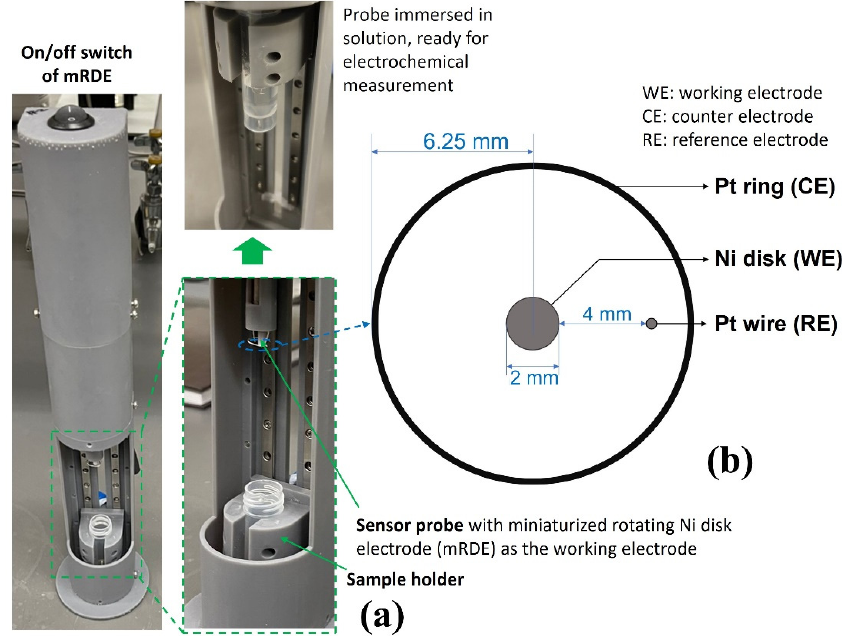
Figure 6. ( a ) UFC ‐ 19 Sensor used in experiments. The testing solution was put in the sample holder and slid up; the sensor probe was immersed in the testing solution for electrochemical sensing af ‐ terward. ( b ) Dimension of the electrodes of the UFC ‐ 19 sensor probe. The 3 electrodes were attached to Gamry Reference 600+ Potentiostat for electrochemical measurement.